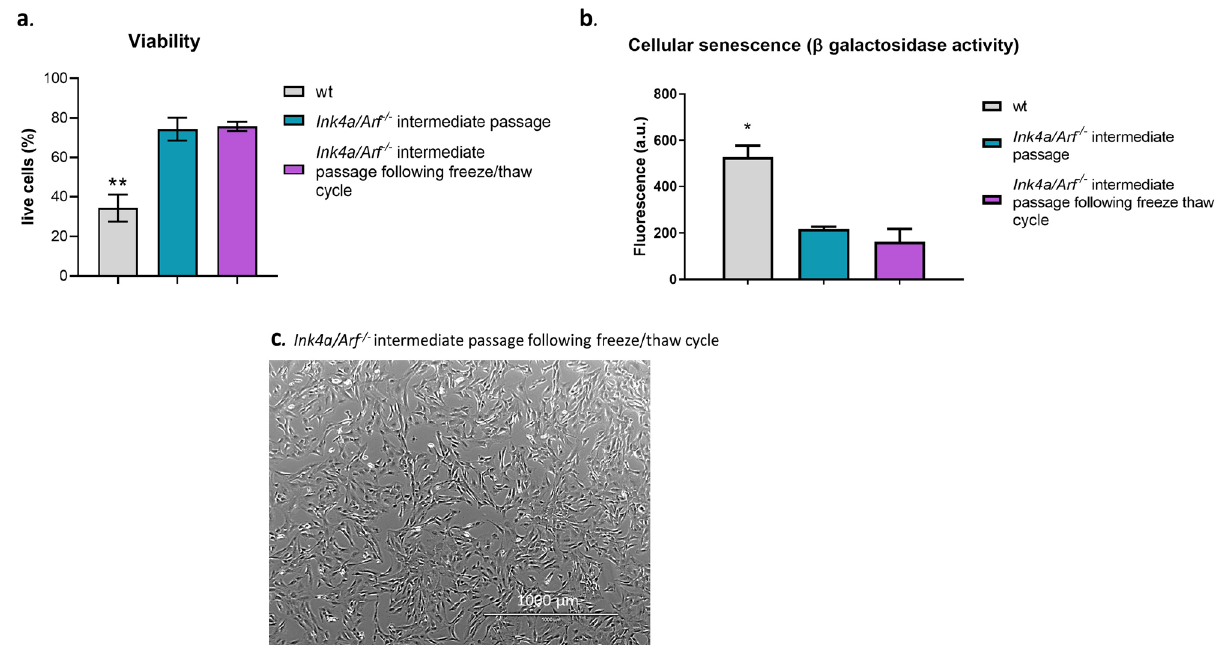
Figure 3. Tenocytes from Ink4a/Arf − / − mice maintain their viability, low senescence and tenogenic